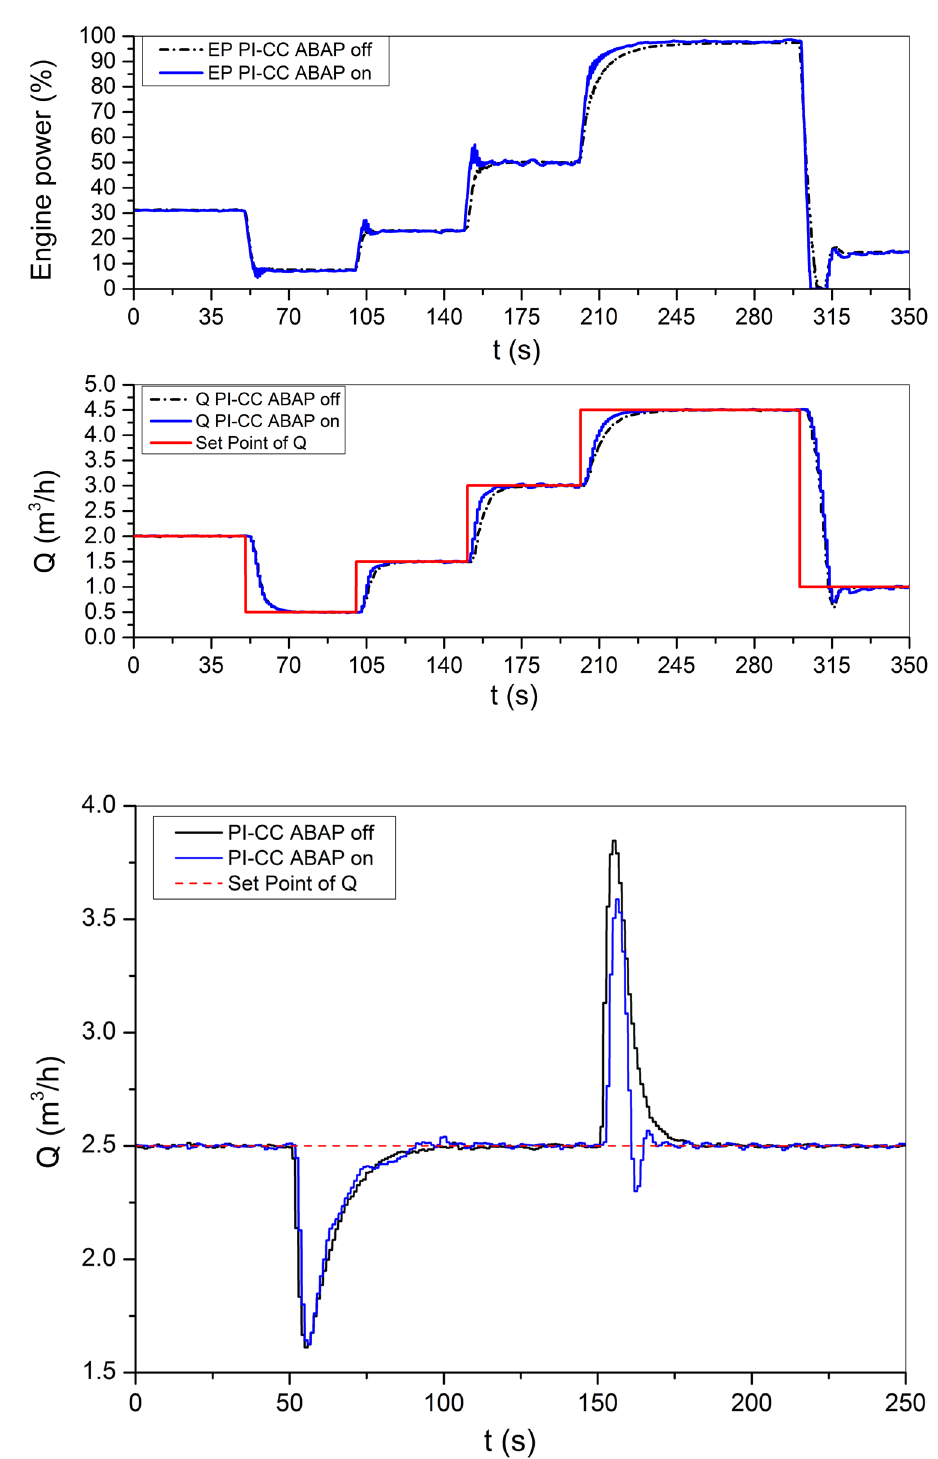
Fig. 10 Flow rate and pump power in function of time dur- ing test of variation of set point with auto-tuning feature on/off